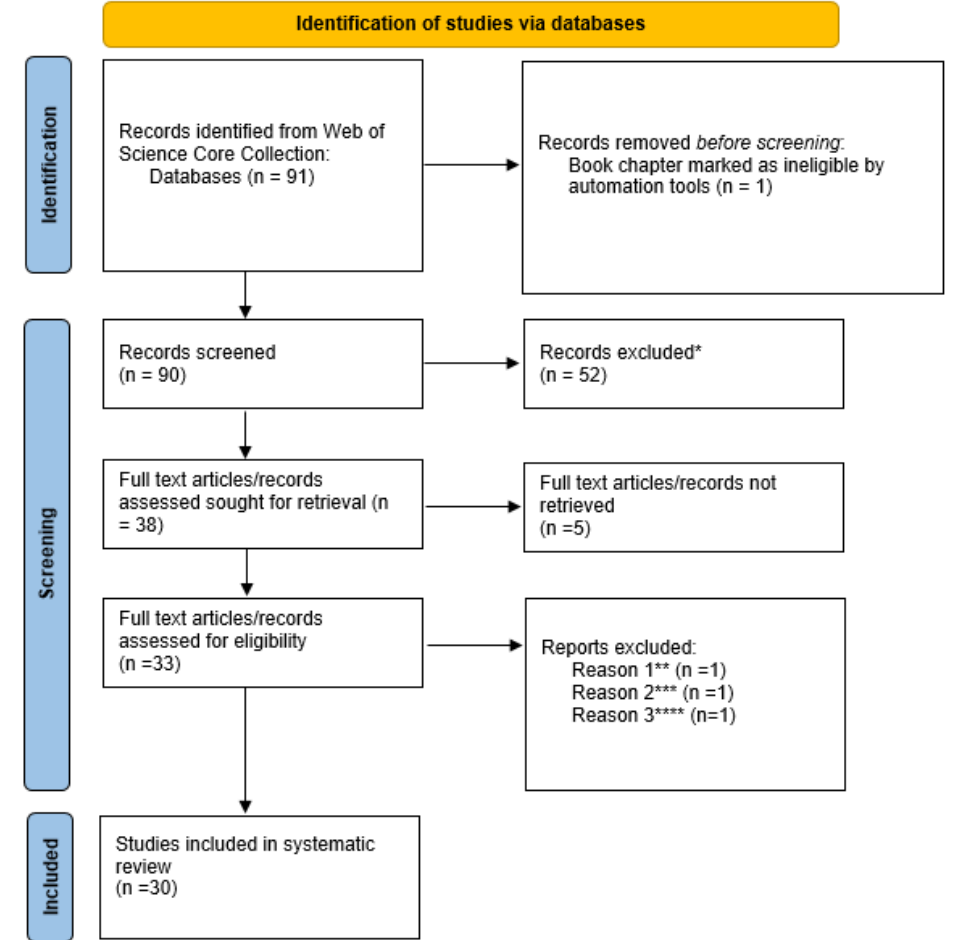
Figure 2. Preferred Reporting Items for Systematic Reviews and Meta-Analyses (PRISMA) analysis flow, which deals with sustainable passenger ports. * The exclusions correspond to the articles that were removed after reading abstracts. Article does not apply to sustainable passenger ports. ** This study does not apply to passenger ports. *** This paper deals with intermodal passenger terminals.